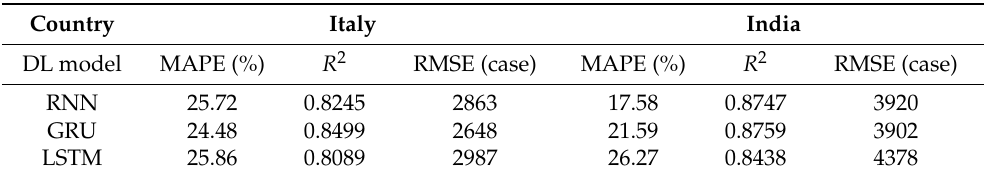
Table 5. Performance metrics of RNN, GRU, and LSTM DL algorithms during the testing period (Italy and India).